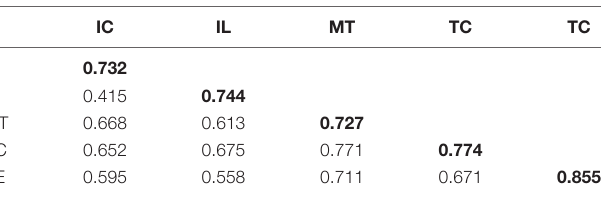
TABLE 2 | Construct